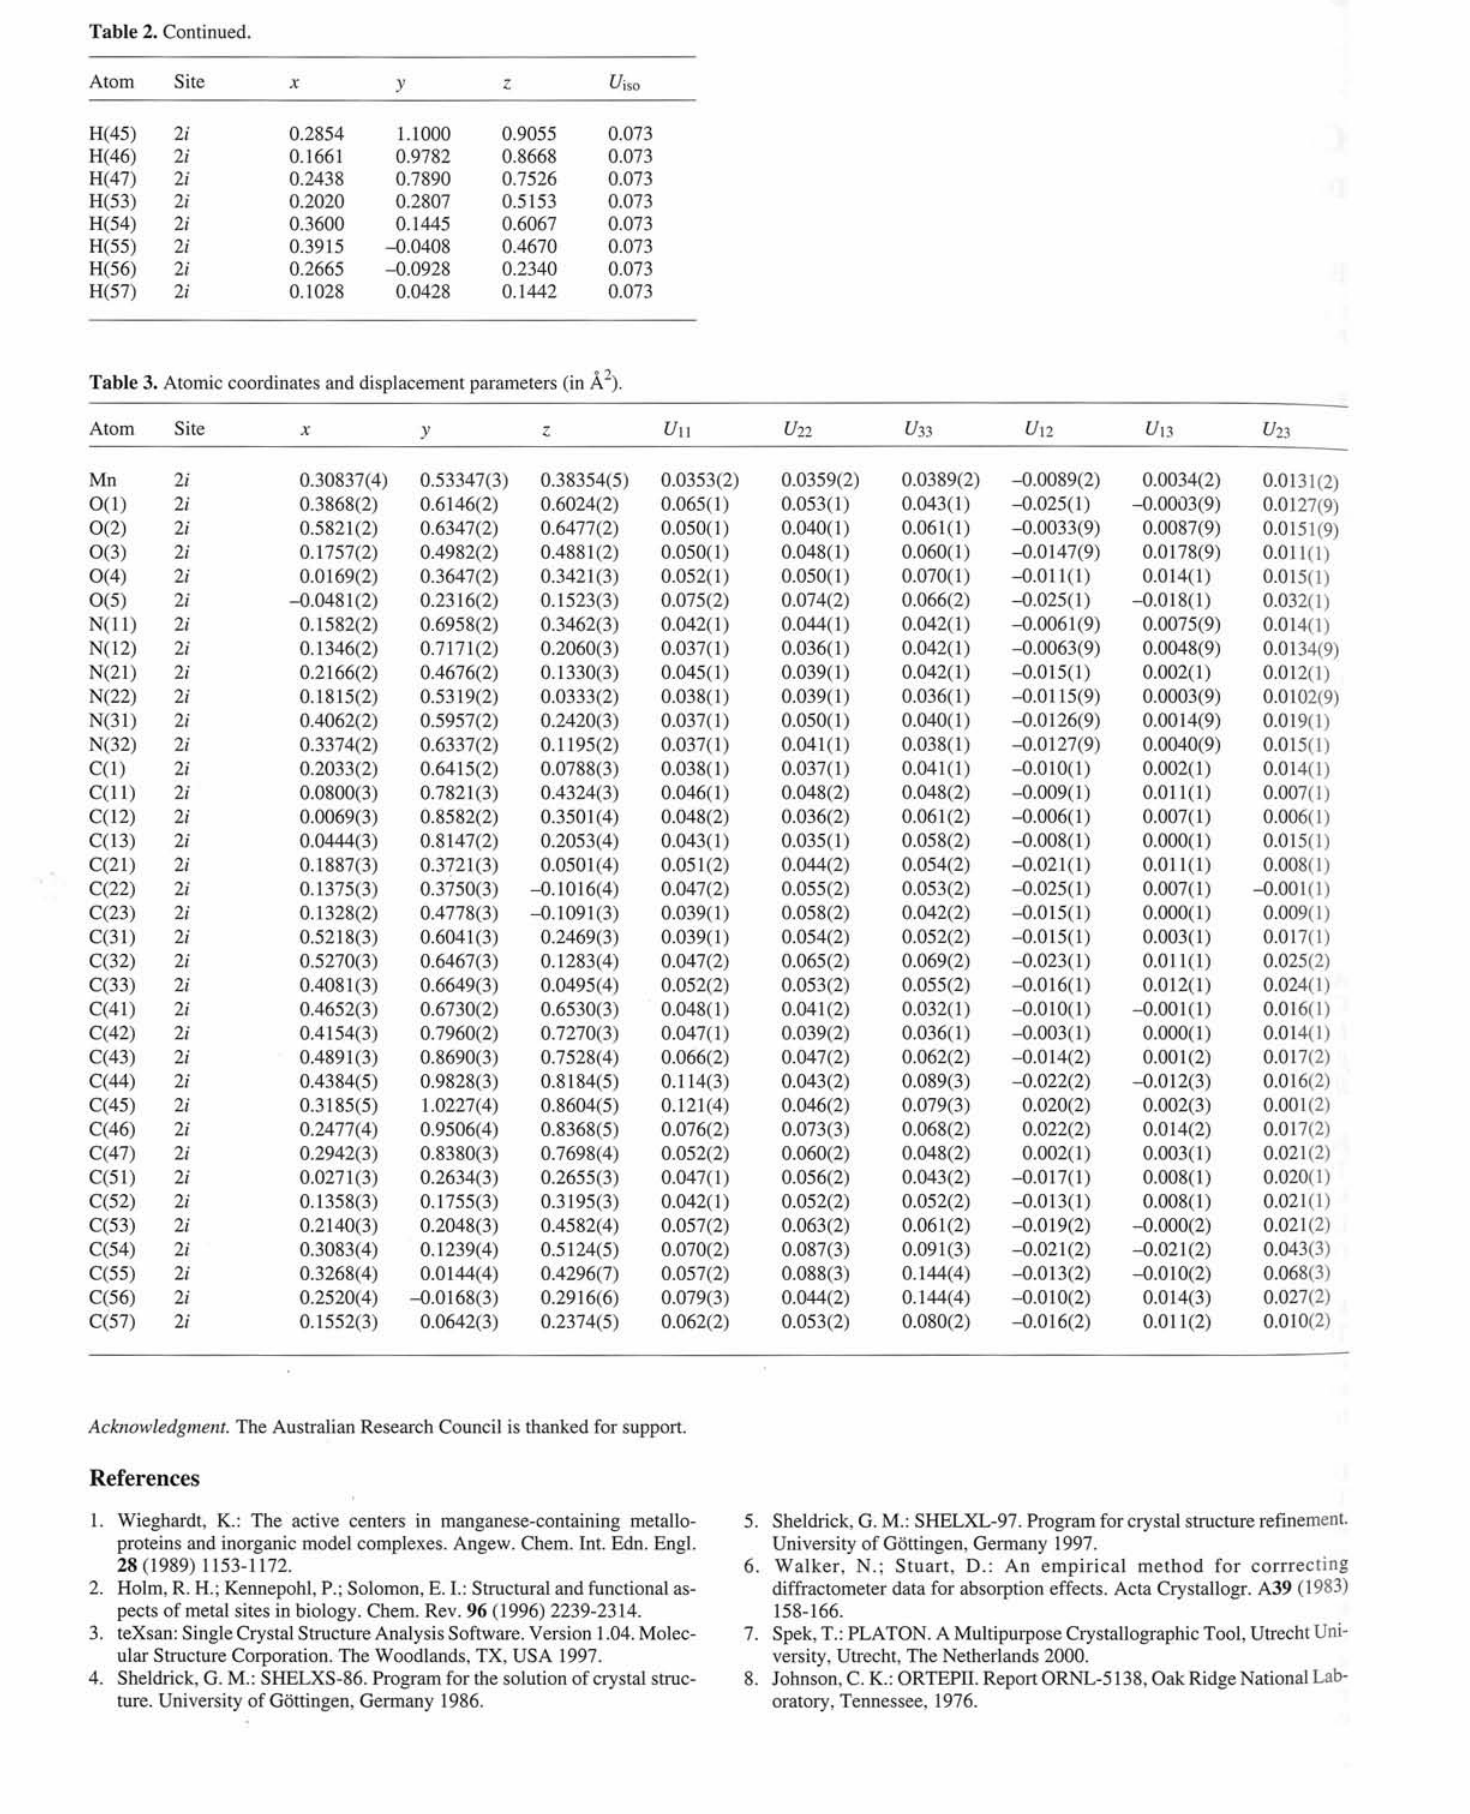
Table 3. Atomic coordinates and displacement parameters (in